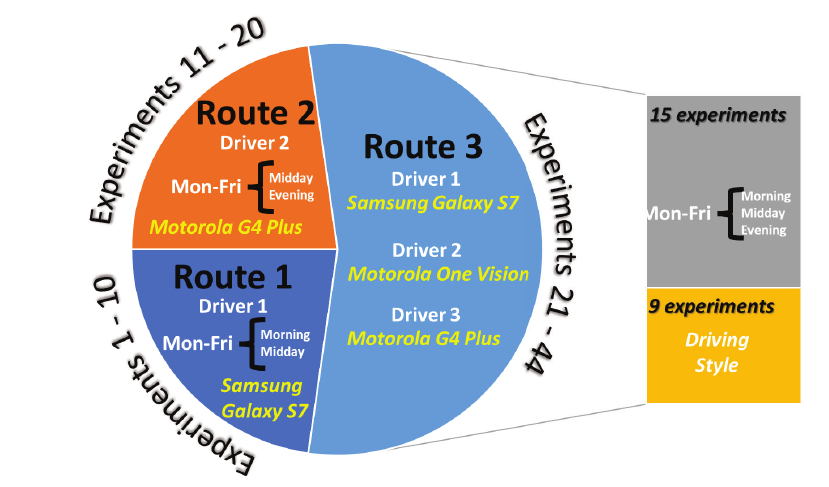
Figure 3. Experiments conditions to train and validate the algorithms of the proposed human–vehicle interaction monitoring